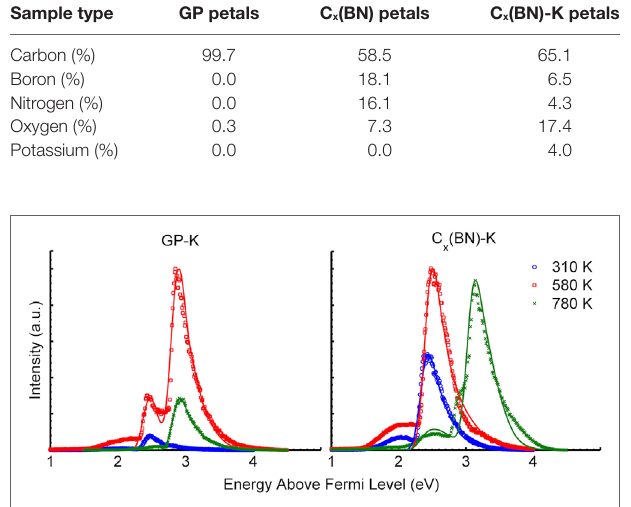
FigUre 5 | X-ray photoelectron spectroscopy survey analysis of graphitic petals, C x (BN) petals, and C x (BN)-K